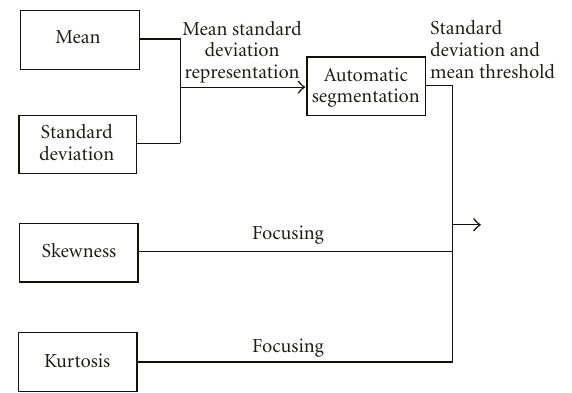
Figure 5: Main structure of the proposed detection